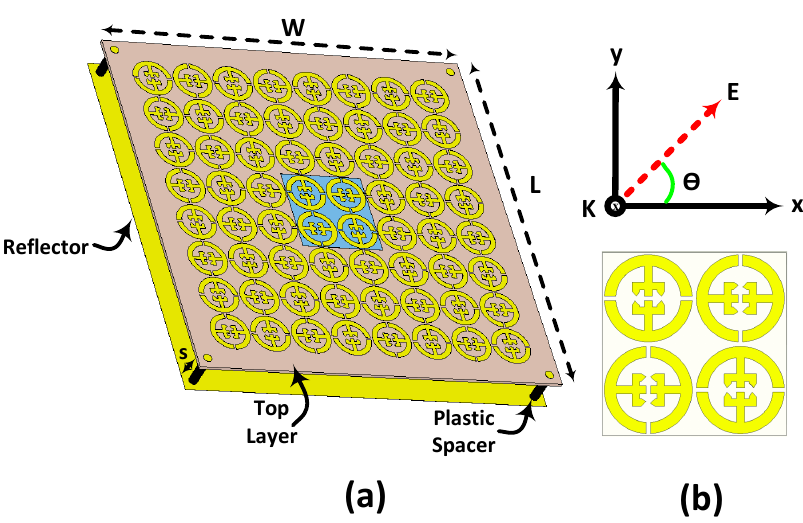
Figure 10. Geometry of the proposed dual polarized planar metasurface: ( a ) a perspective view of the proposed dual polarized planar 8 × 8 metasurface and ( b ) a 2 × 2 super unit cell with vector representation showing the different incident polarization angles of E-field.